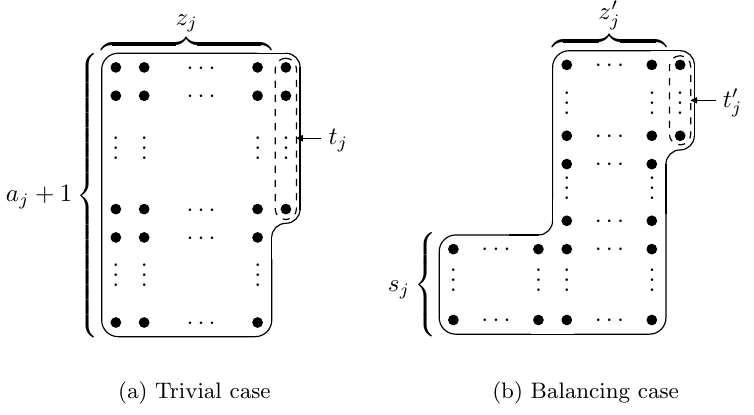
Figure 11: Graphical representation of the discretisation